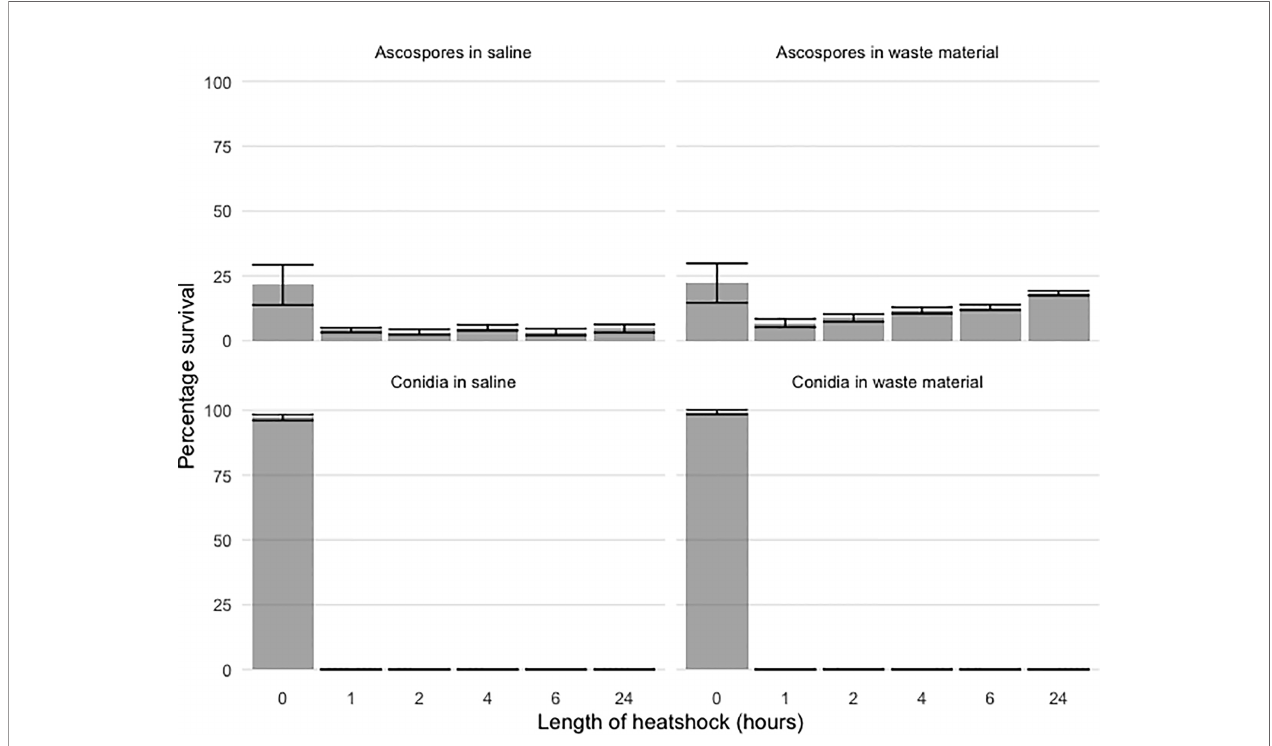
FIGURE 1 | Percentage survival of spiked ascospore and conidial after 70°C heat shock of 1h, 2h, 4h, 6h, 24h. The datapoints represent colony counts of single measurements of biological duplicates and depicted is the mean +/- SEM as indicated with the error bars. Both A. fumigatus ascospores and conidia were spiked at different concentrations ranging from 10 3 to 10 7 for conidia and 10 2 to 10 4 for ascospores in either saline (left panels) or fl ower bulb waste material (right panels). Percentage survival is depicted for ascospores (upper panels) and conidia (lower panels) and show clear differences; while conidia cannot survive a one-hour heat shock, ascospores are initially decreased after the fi rst one-hour heat shock but especially for the spiked ascospores in fl ower bulb waste material, germination is rising back again to the initial levels that were detected before the start of the heat shock. The initial peak of viability in the two upper panels is due to condia attached to the fruiting body